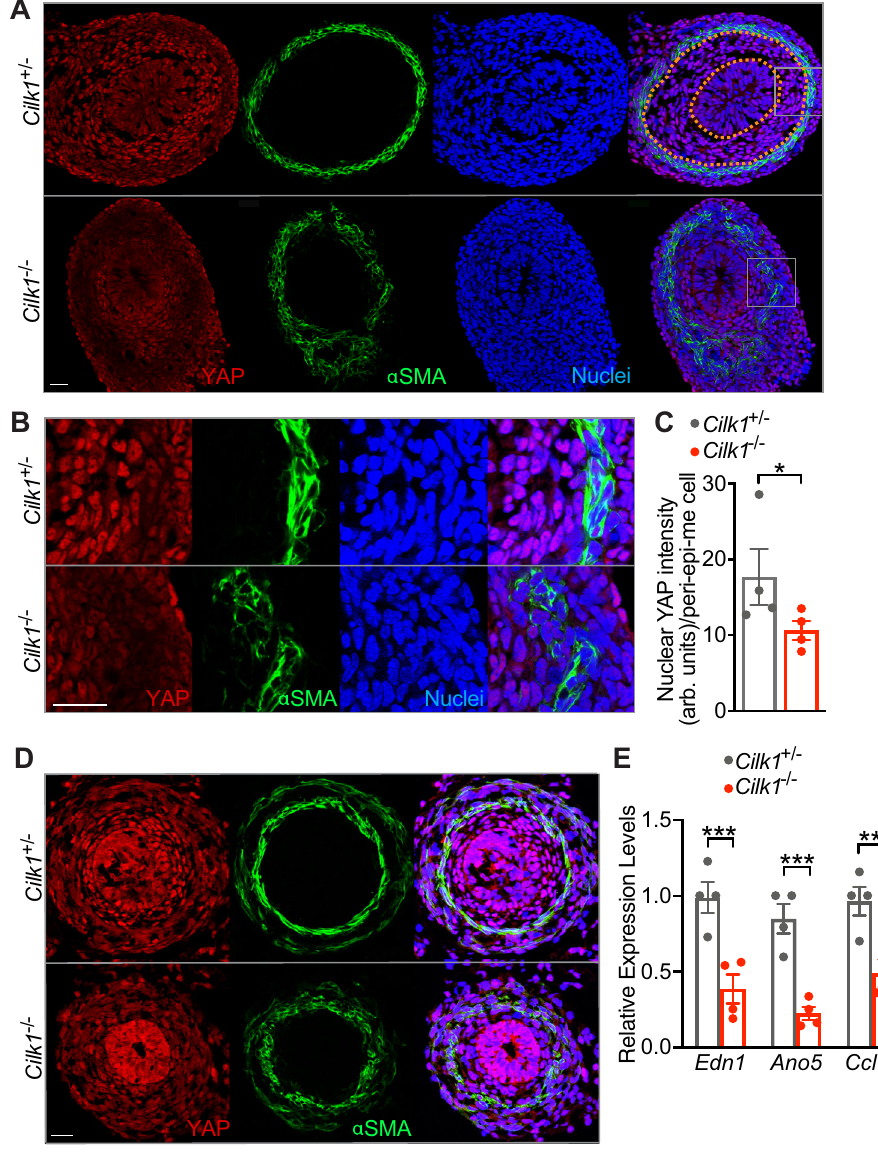
Fig. 4 YAP nuclear levels and activity depend on CILK1. A Immuno fl uorescence staining of E13.5 Cilk1 + /- and Cilk1 − / − intestines for YAP (red), smooth muscle ( α SMA, green), and nuclei (Hoechst, blue). Scale bar, 25 μ m. Orange dotted lines outline the epithelium and smooth muscle cell boundaries, in between are the peri-epithelial mesenchymal cells. B Magni fi cations of the boxed areas from A . Scale bar, 25 μ m. C Nuclear YAP intensities of peri- epithelial mesenchymal (peri-epi-me) cells in E13.5 Cilk1 + /- ( n = 4) and Cilk1 − / − ( n = 4) intestines. For each intestine, the nuclear YAP intensity per cell was averaged from three sections. Values are presented as means± SEM. * p = 0.0176 by two-sided ratio paired t test. D Immuno fl uorescence staining of E14.5 Cilk1 + /- and Cilk1 − / − esophagi for YAP (red), smooth muscle ( α SMA, green) and nuclei (Hoechst, blue). Scale bar, 25 μ m. E Relative levels of End1 , Ano5 , and Ccl11 mRNA of E13.5 control Cilk1 + /- ( n = 4) and Cilk1 − / − ( n = 4) intestines. Values are presented as means ± SEM. ** p < 0.01 and *** p < 0.001 by two-sided unpaired t test (0.0051 for Edn1 , 0.0011 for Ano5 and 0.0114 for Ccl11 ). Source data are provided in the Source Data fi